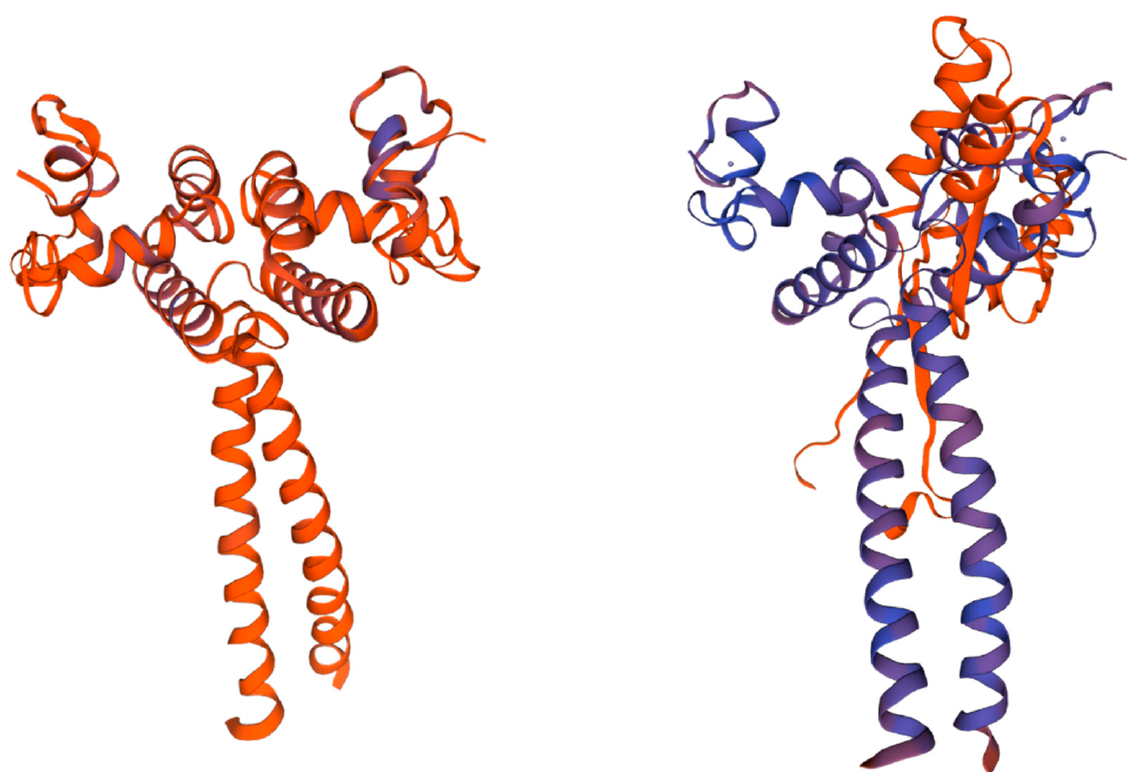
Figure 3. Tertiary structure of horsetail pine LBD protein. Model with multiple α -helices, less irregular curl and β -turn, no β -folding found. (left: PmLBD44 vs. right: PmLBD47 ).